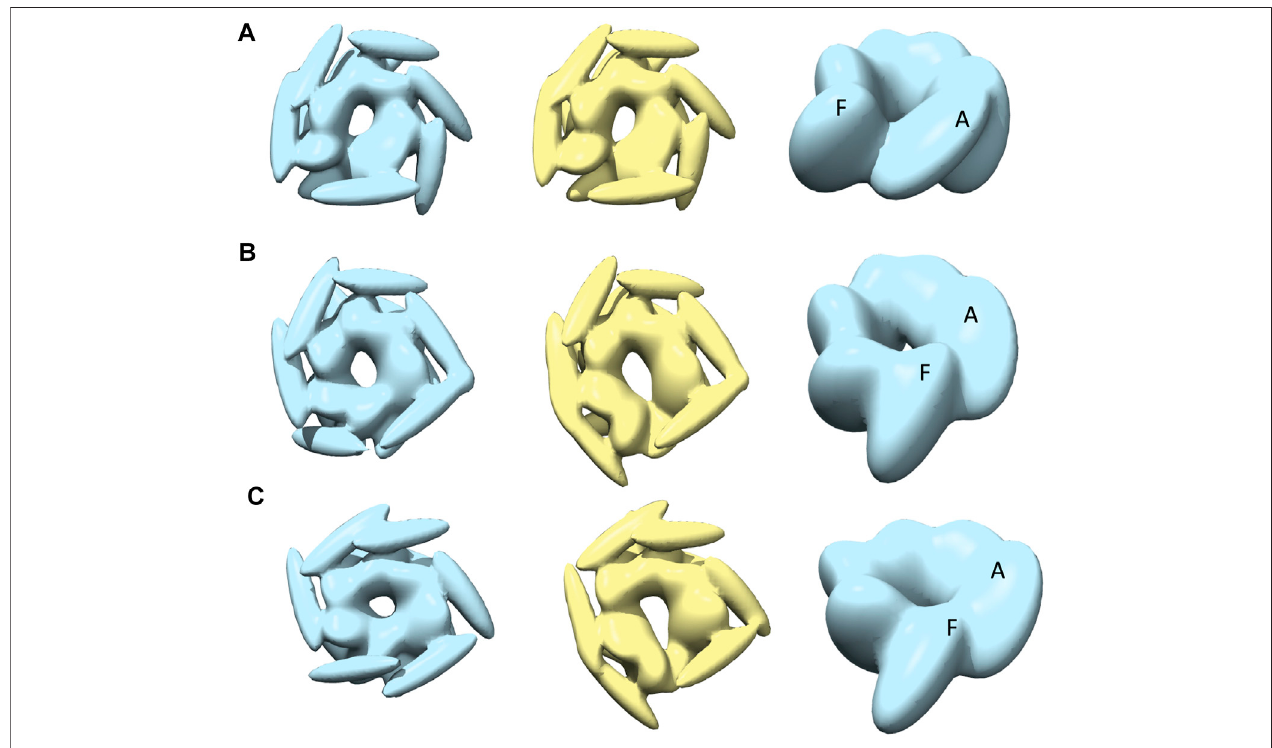
FIGURE6| ThemostconvergedmodelbetweenstructuralmodellingstartingfromR(lightblue)andS(yellow)forclosedclassAFMimages.Therows (A – C) arefor AFM images 7, 8 and 9, respectively.